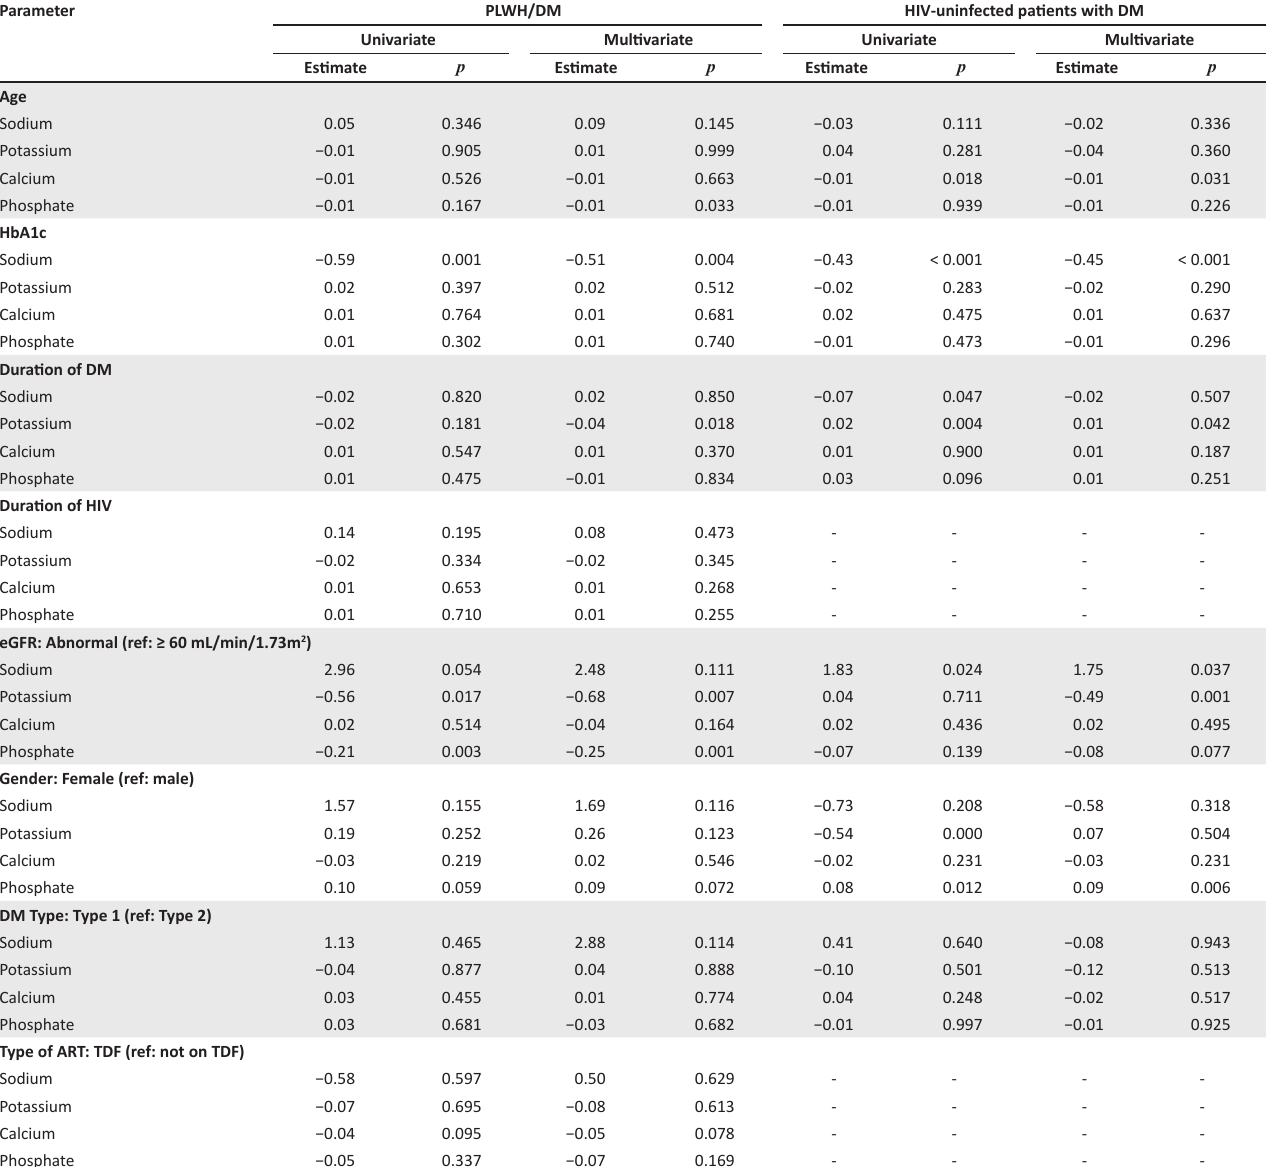
TABLE 4: Linear regression analysis for the associations of electrolytes with clinical factors in people living with human immunodeficiency virus and diabetes mellitus, and human immunodeficiency virus-uninfected patients with diabetes mellitus. Parameter